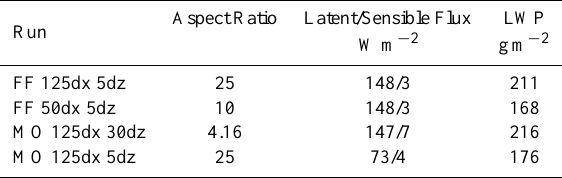
Table 1. Selection of runs used during sensitivity studies. FF runs use specified surface fluxes and identical vertical spacing to investi- gate sensitivity of LWP to horizontal grid spacing. MO runs calcu- late fluxes using Monin-Obukhov similarity theory and investigate the effects of first grid cell aspect ratio on the calculated